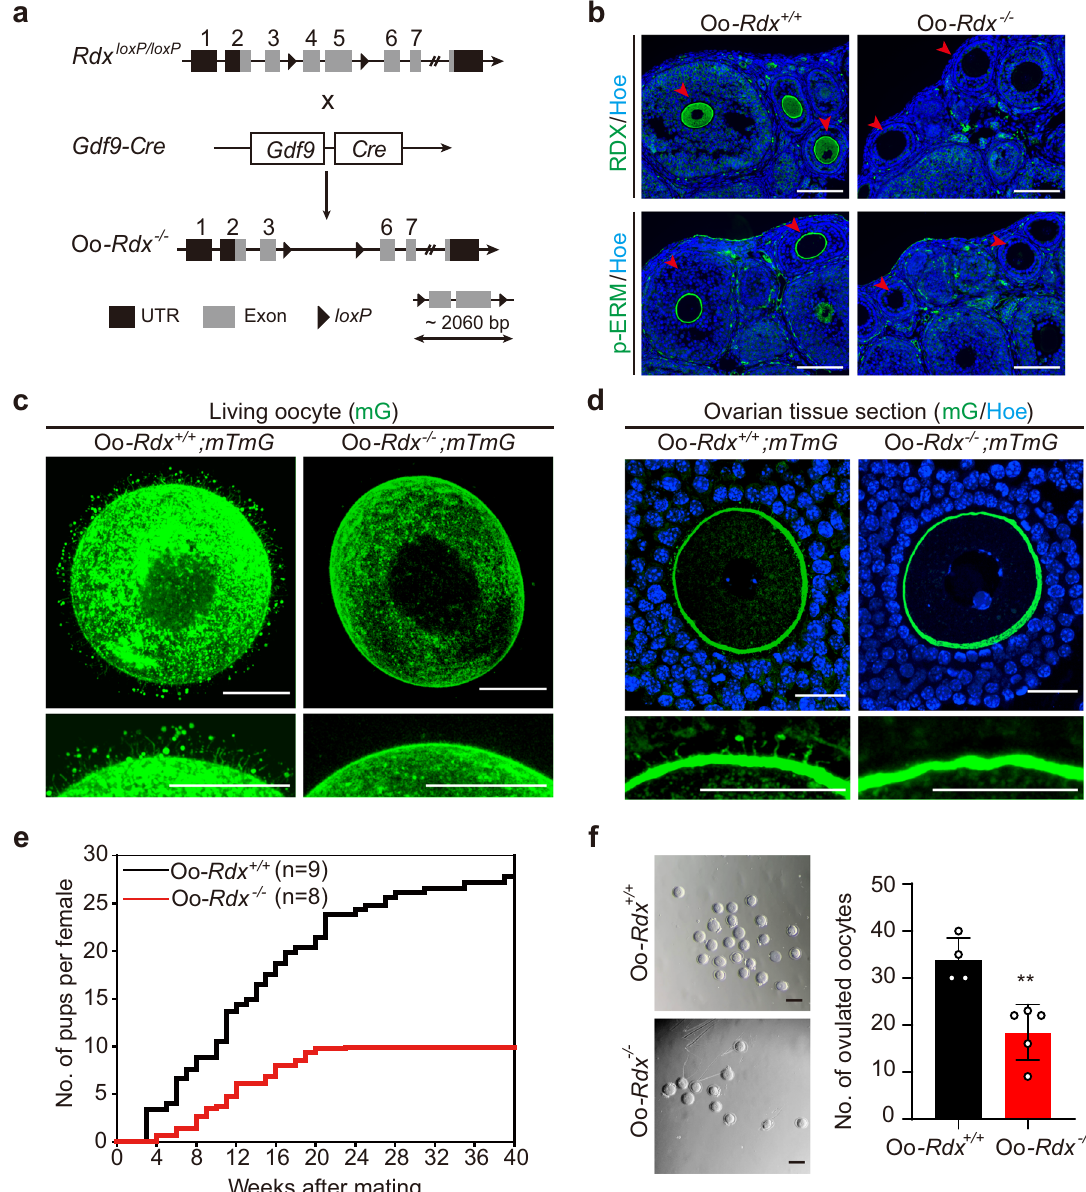
Fig. 3 Deletion of Rdx in oocytes led to a failure of Oo-Mvi formation and shortened reproductive lifespan in females. a Schematic representation of the deletion of Rdx exons 4 and 5 by Gdf9-Cre -mediated recombination in oocytes of Oo -Rdx − / − . b Immuno fl uorescence detection of RDX and p-ERM showing successful deletion of RDX in oocytes (arrowheads) of Oo -Rdx − / − . n = 6 ovaries per group. c , d Imaging the living oocytes ( c ) and ovarian tissue sections ( d ) showing a failure of the construction of Oo-Mvi on the oocyte surface in Oo- Rdx − / − ;mTmG females. n = 40 Oo- Rdx + / + ;mTmG and 16 Oo- Rdx − / − ;mTmG oocytes ( c ), 12 Oo- Rdx + / + ;mTmG and 9 Oo- Rdx − / − ;mTmG ovaries ( d ). e Fertility check showing a subfertility phenotype in the Oo- Rdx − / − females with signi fi cantly decreased litter size and number and a shortened reproductive lifespan ( n = 8) compared to that in Oo- Rdx + / + mice ( n = 9) during 40 weeks of mating. f A signi fi cantly lower ovulated oocyte number in Oo- Rdx − / − females ( n = 5) compared to that in Oo- Rdx + / + mice ( n = 4), indicating that the abnormal development of oocytes caused subfertility in Oo- Rdx − / − females. P -value = 0.0036. Representative images are shown. Data are presented as the mean ± SD. Data were analyzed by two-tailed unpaired Student ’ s t -test and ** P < 0.01. Scale bars: 100 μ m ( b , f ), 25 μ m ( c , d arrowheads). This localization is consistent with the formation of Oo-Mvi in follicle development, indicating that RDX in oocytes is involved in the formation of Oo-Mvi, and the major function of Cre males to delete Rdx in oocytes at the primordial follicle stage RDX and Oo-Mvi might be related to the growth of oocytes and (Fig. 3a). The resulting Gdf9-Cre;Rdx loxP/loxP mice were referred follicles in the ovary. to as Oo- Rdx − / − mice, and the littermates of No-Cre;Rdx loxP/loxP females, referred to as Oo -Rdx + / + , were used as the control. To validate the ef fi ciency of deletion in Oo- Rdx − / − mice, we per-